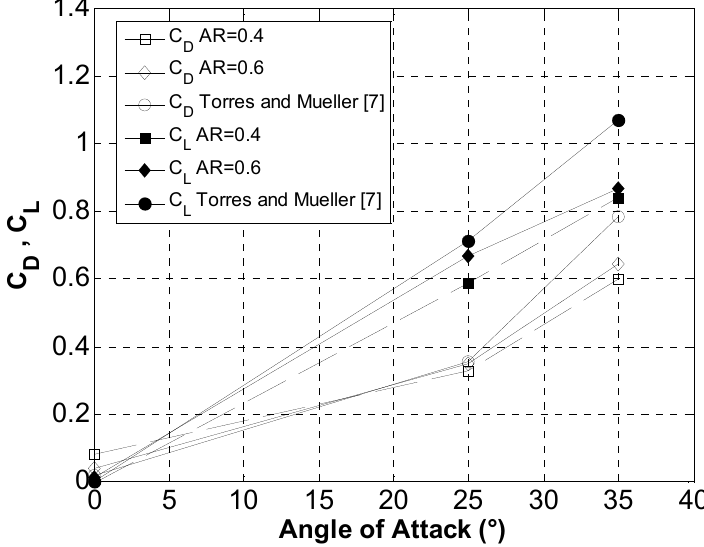
Figure 5. Free stream C L and C D for AR = 0.4 and AR = 0.6 compared with Equations (1a) and (1b).